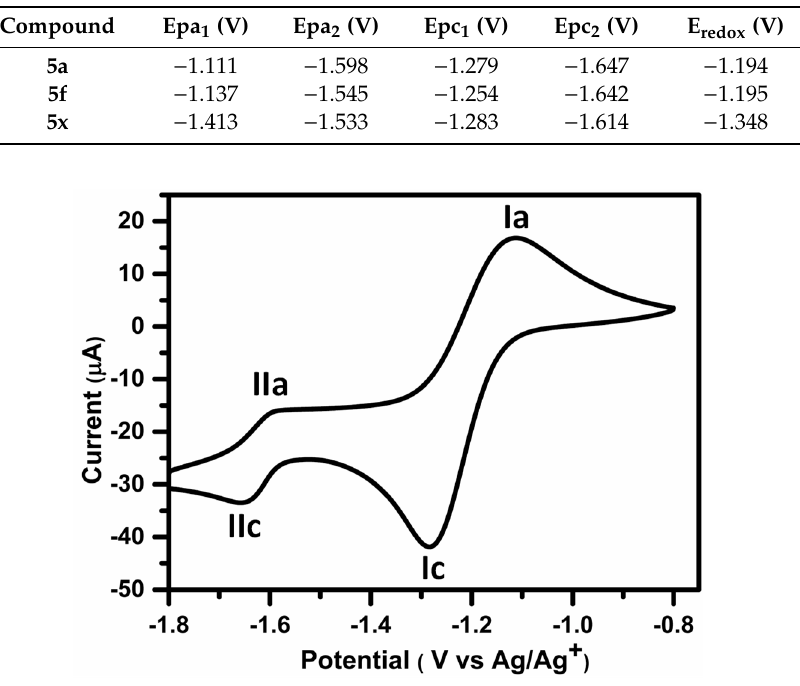
Figure 7. Cyclic voltammetry of 5a (1 mM) in CH 3 CN + Bu 4 NBF 4 (0.1 M) on glassy carbon electrode (GCE) with cathodic direction, potential range: − 0.8 V up to − 2.0 V, v = 0.1 V s − 1 .